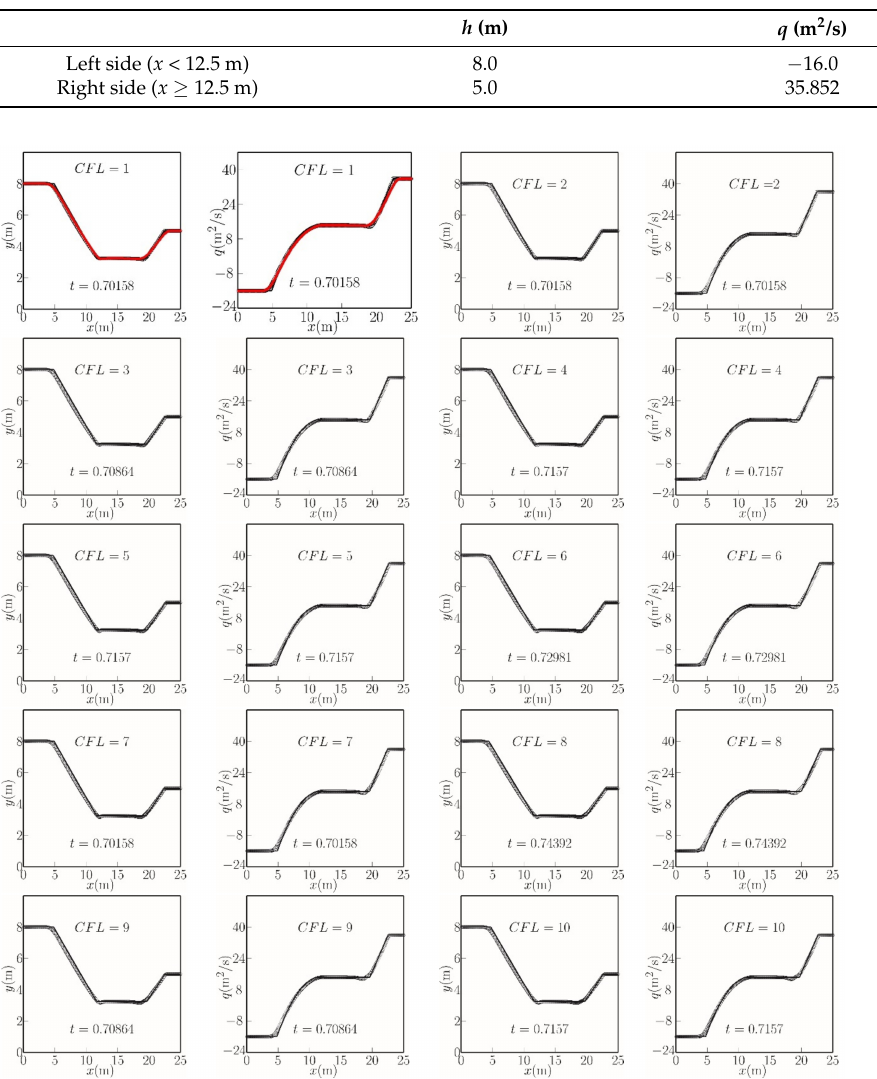
Figure 1. Free surface and mass flux profiles for two rarefaction waves in a frictionless, horizontal channel at a given time instant. Toro’s [2] almost exact solution (solid lines), Roe’s [3] scheme (red circles), and TVD-LTS predictions (open circles) for CFL = 1 to